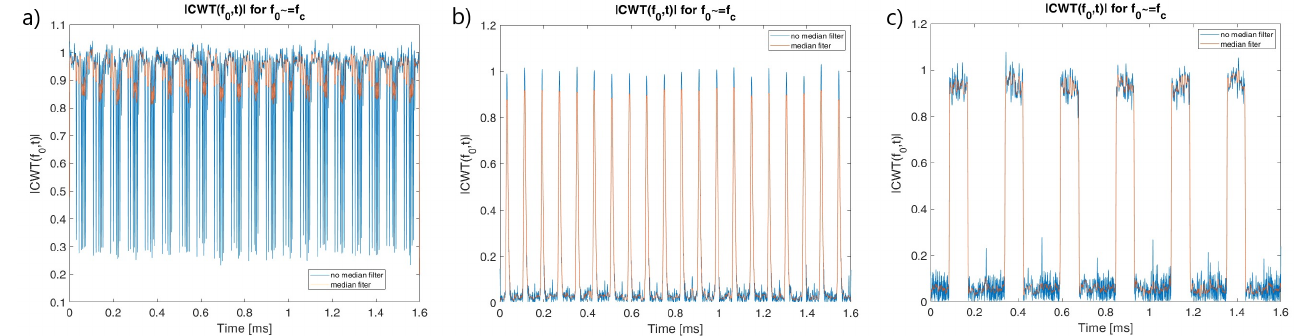
Figure 6. | CWT ( f 0 , t ) | for f o ∼ = f c (Morse wavelet used with γ = 27, β = 27): ( a ) PCCW. ( b ) LFMCW. ( c )